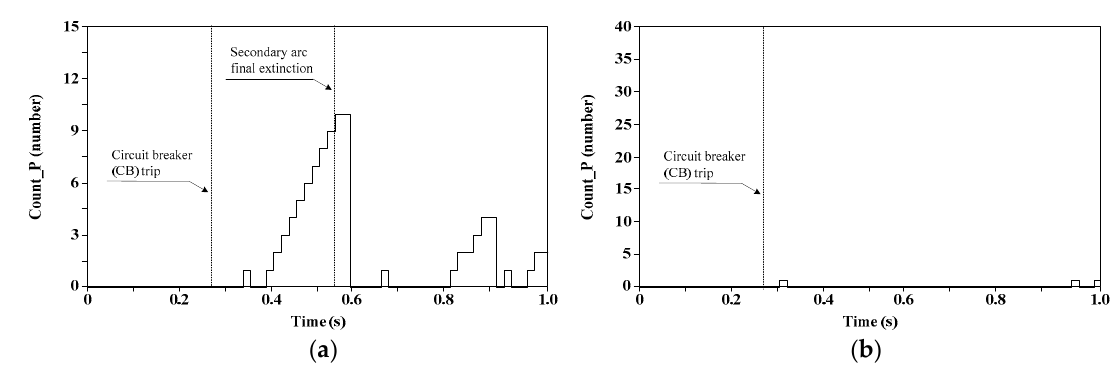
Figure 8. Results of Count_P for transient and permanent faults: ( a ) transient; ( b ) permanent.